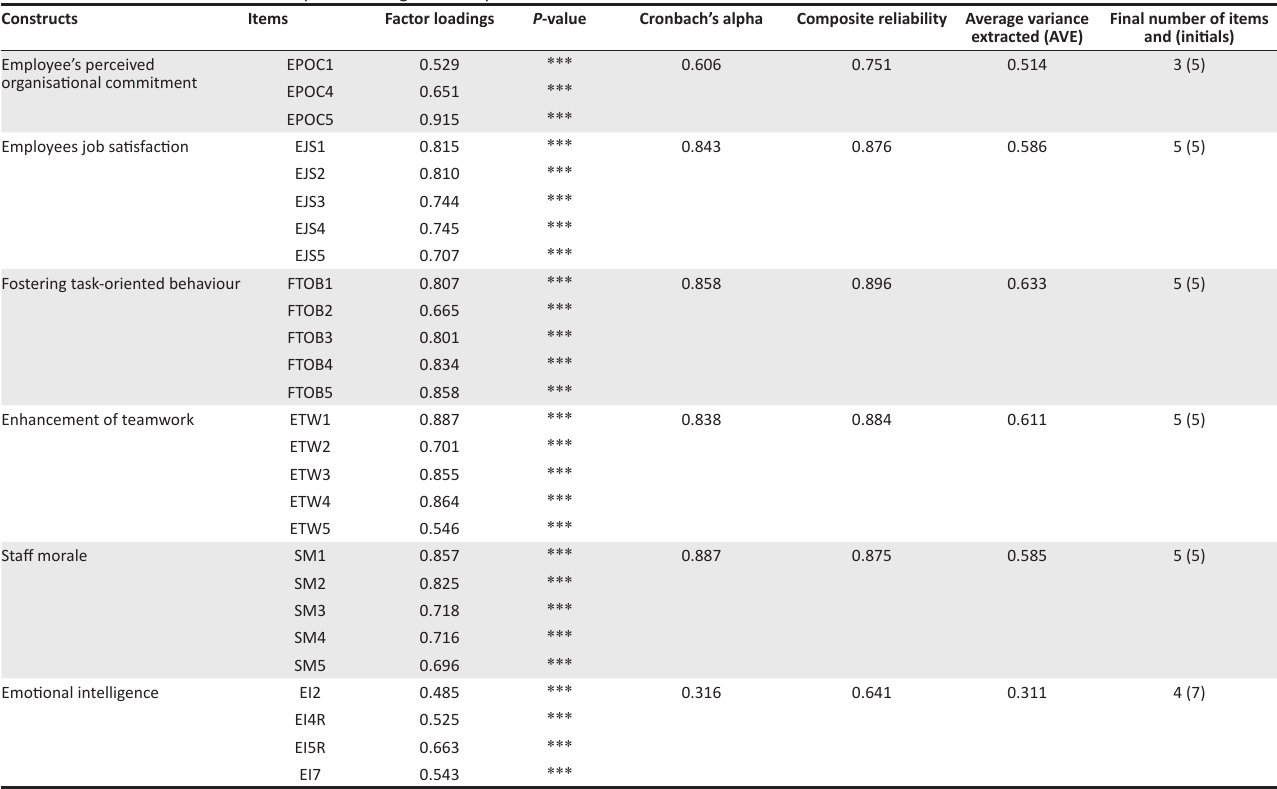
TABLE 2: Statistical evidence of reliability and convergent validity.